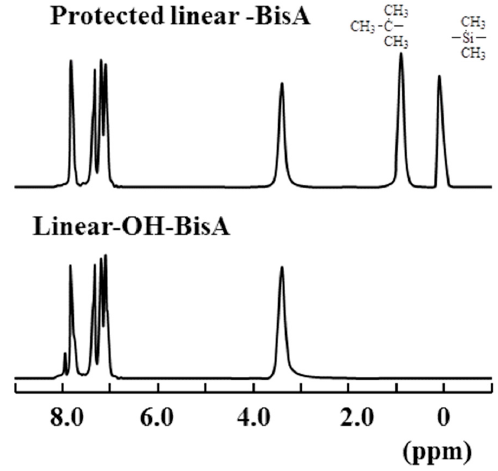
Figure 2. 1 H-NMR spectra of protected Linear-OH-BisA and Linear-OH-BisA .